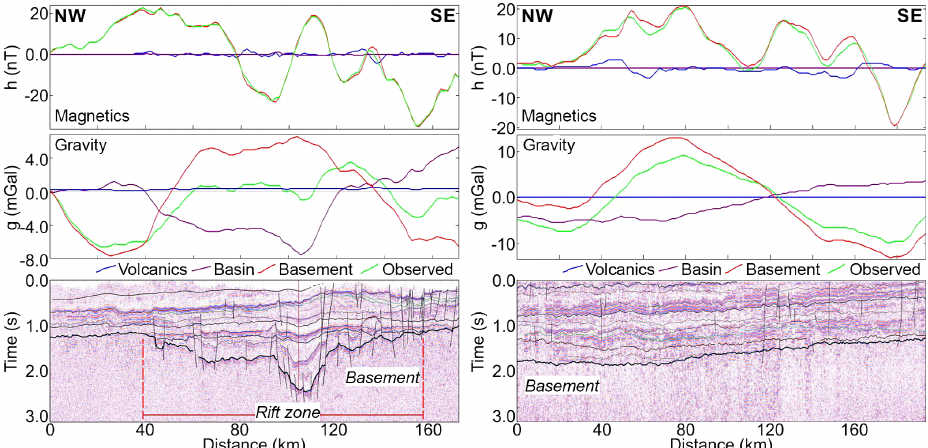
Figure 12. Observed and calculated residual reduced-to-pole magnetic and gravity anomalies along seismic lines L507 (left) and L304 (right) (location in Fig. 4). The basin anomalies are calculated from the seismic basin geometry. The theoretical basement curves were obtained by subtracting the basin anomalies from the observed data.